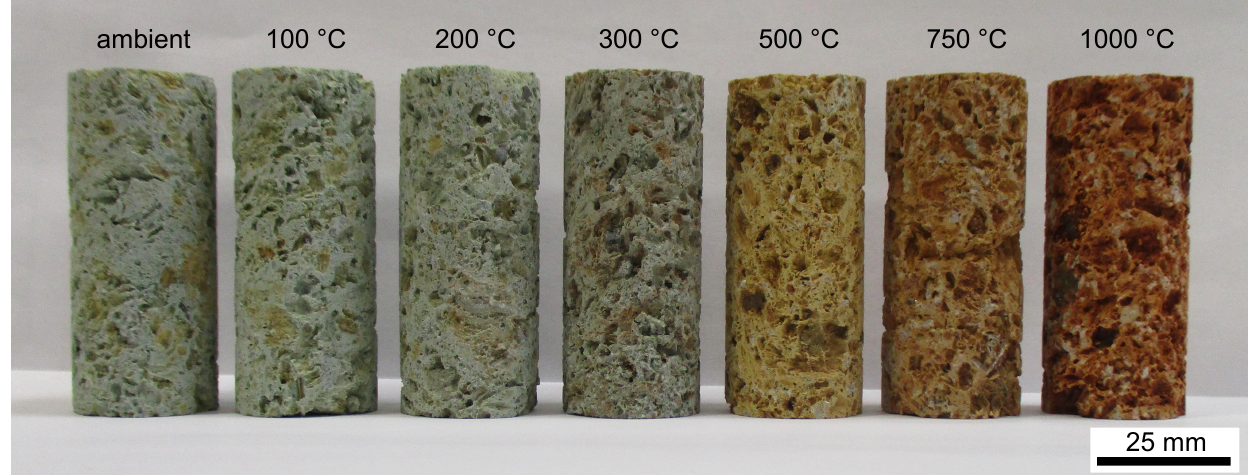
Figure 4: Photograph of a suite of thermally stressed samples of Mt. Epomeo Green Tu ff (MEGT). Temperature quoted above each sample is the thermal stressing temperature. “Ambient” (i.e. ambient temperature) indicates a sample that underwent no thermal